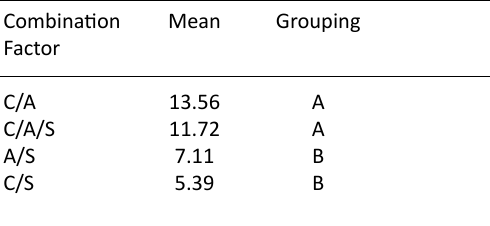
Fig. 1. The antibacterial susceptibility of combination of plant extract combination with 95% confidence intervals (CI) for the mean. C/A: combination of Camellia sinensis with Azadirachta indica ; C/S: combined with Camellia sinensis and Cassia acutifolia ; A/S: combined with Azadirachta indica and Cassia acutifolia ; C/A/S: combinations of all three medicinal plant together Camellia sinensis , Azadirachta indica and Cassia acutifolia. Table 5. Tukey Pairwise Comparison of antibacteria susceptibility of combined action of plant extracts at p-value 0.001 against bacterial